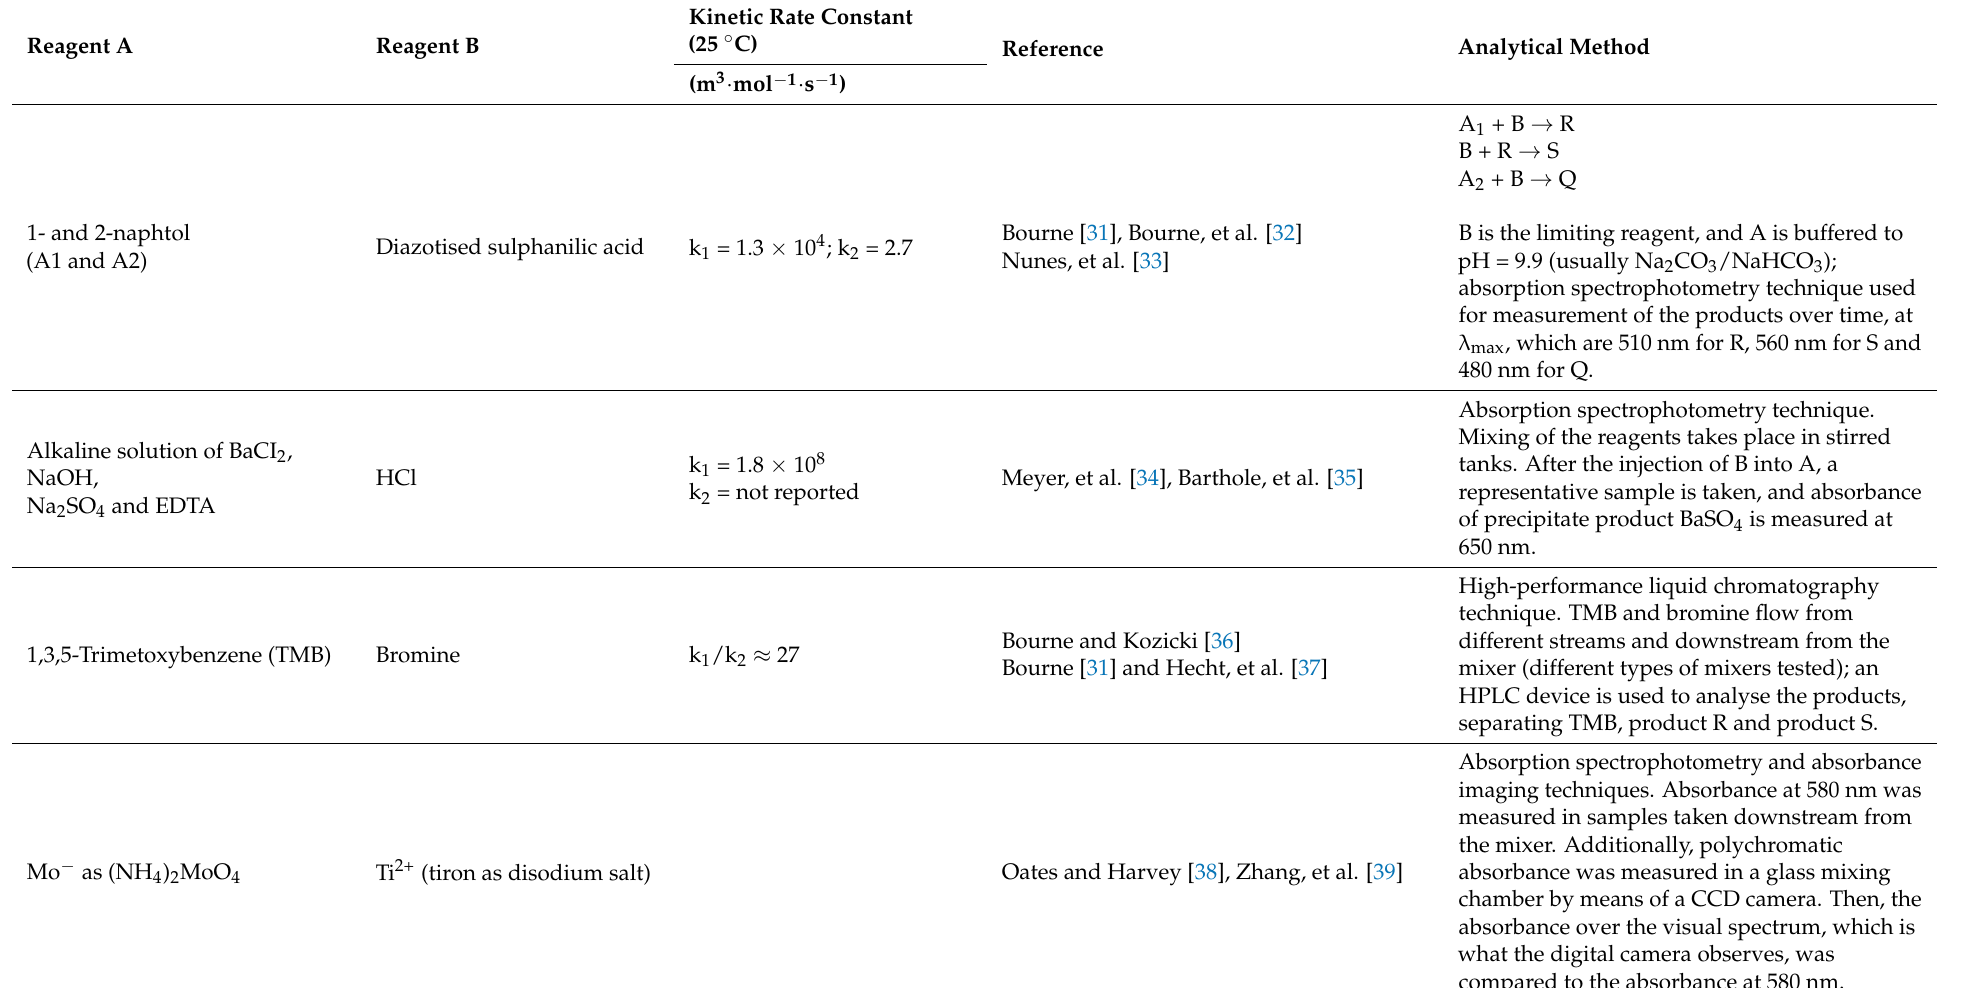
Table 1. Operational parameters for several chemical methods for assessing micromixing, based on competitive-consecutive reactions A + B → R; R + B →